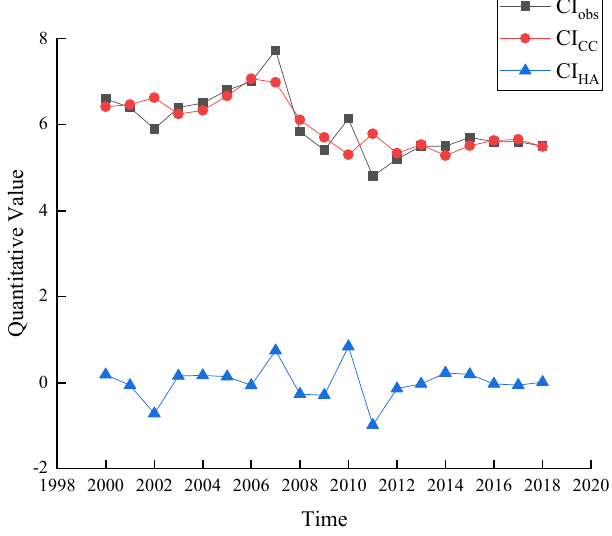
Figure 6. The difference between CI obs and CI CC and CI HA.